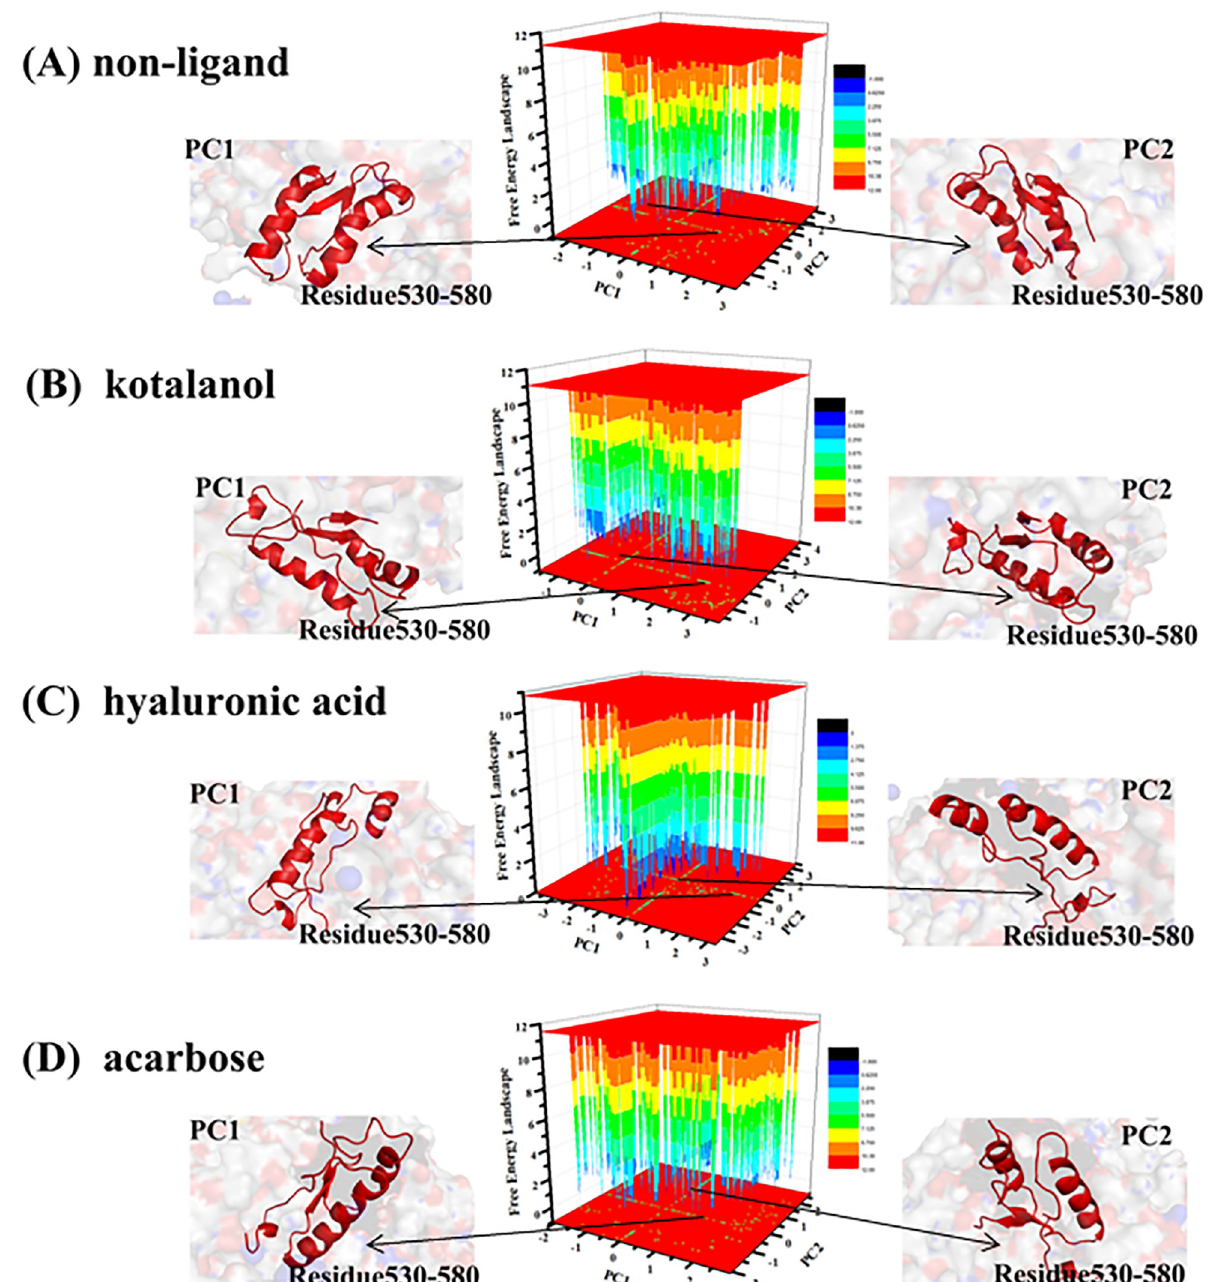
Fig 8. Free energy landscape (FEL) and structures of the two most stable structures of the four systems. The α helix in residue 530–580 (A) ADA. (B) ADA-FR0 complex. (C) ADA-FR2 complex. (D) ADA-PRH complex.